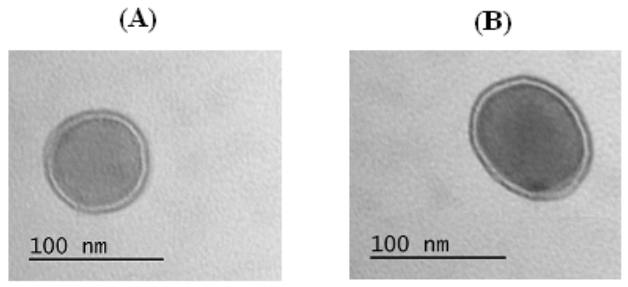
Figure 9. TEM images of GP2 polymersomes loaded with model dye (bromophenol blue): ( A ) encapsulation efficiency 16%; and ( B ) encapsulation efficiency 21%.